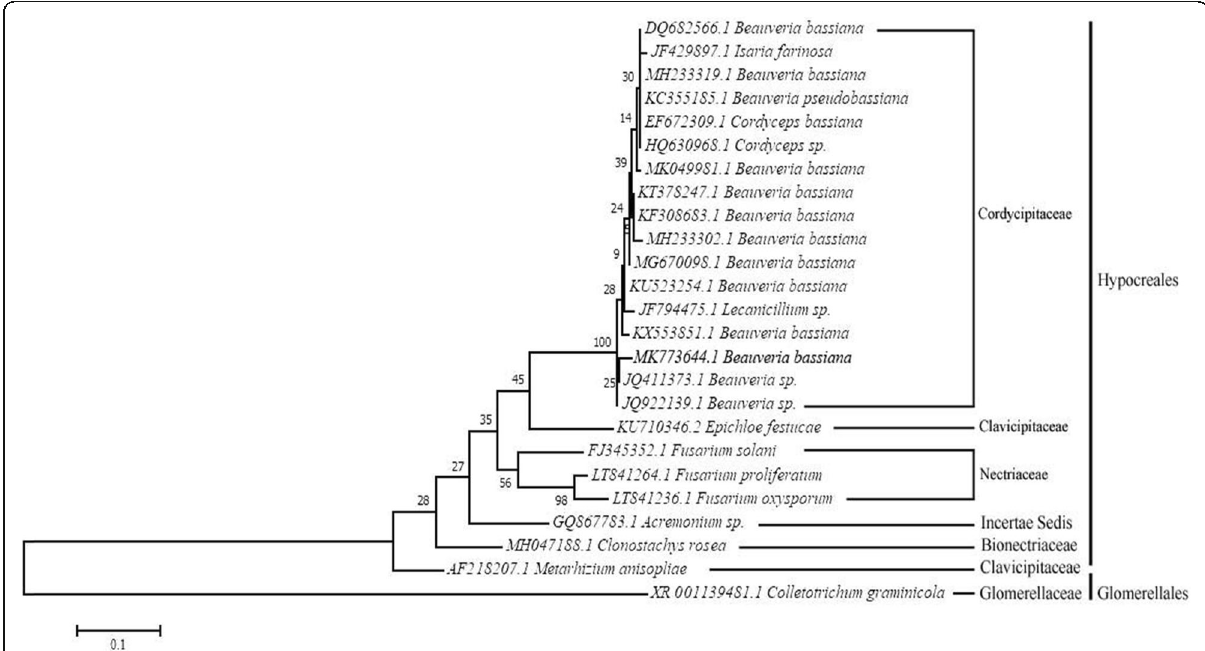
Fig. 2 Molecular phylogenetic analysis by Maximum Likelihood method based on the Jukes-Cantor model. The tree with the highest log likelihood ( − 3386.08) is shown. The percentage of trees in which the associated taxa clustered together is shown next to the branches. Initial tree(s) for the heuristic search were obtained automatically by applying the Maximum Parsimony method. The tree is drawn to scale, with branch lengths measured in the number of substitutions per site. The analysis involved the nucleotide sequences of 25 species. There were 545 positions in the final dataset. Evolutionary analyses were conducted in